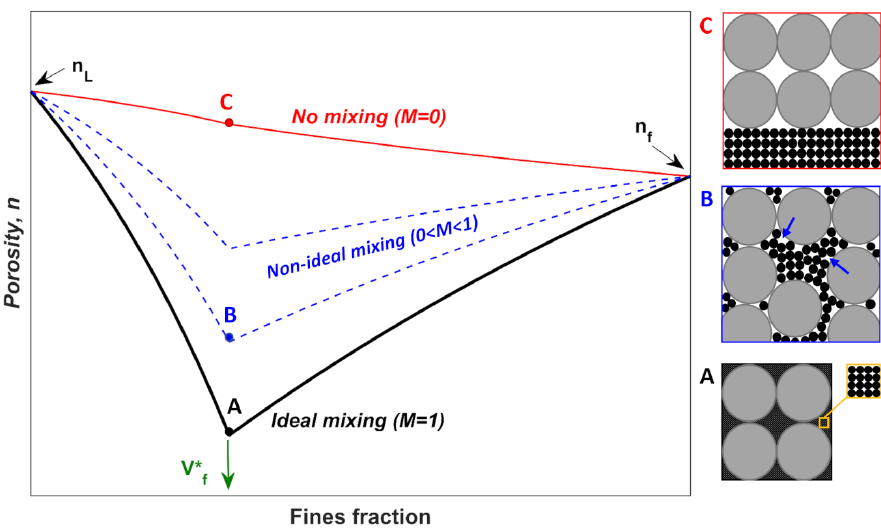
Figure 1. Illustration of binary mixture porosity variation as function of fines fraction. The ideal mixing case ( black curve ) results in lowest porosity at any given fines fraction compared to non- ideal ( blue curves ) and no-mixing ( red curve ) cases. M refers to the mixing correction parameter in Equations (1) and (2). Schematic drawings of the corresponding packing for points ( A – C ) are shown to the right of the plot. Blue arrows in schematic drawing ( B ) refer to large pore space introduced due to packing disturbance. Figure is modified after